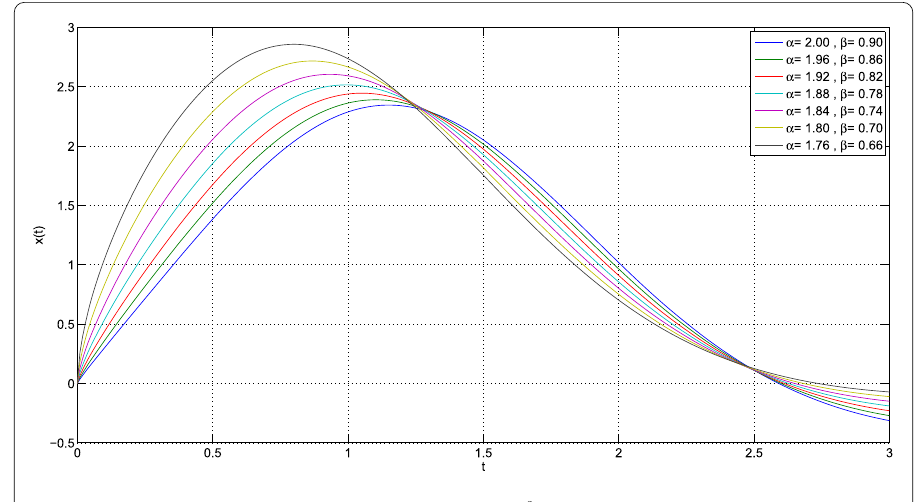
Figure 1 Graph showing x ( t ) for (6.1) with ψ ( t ) = sin α ( t